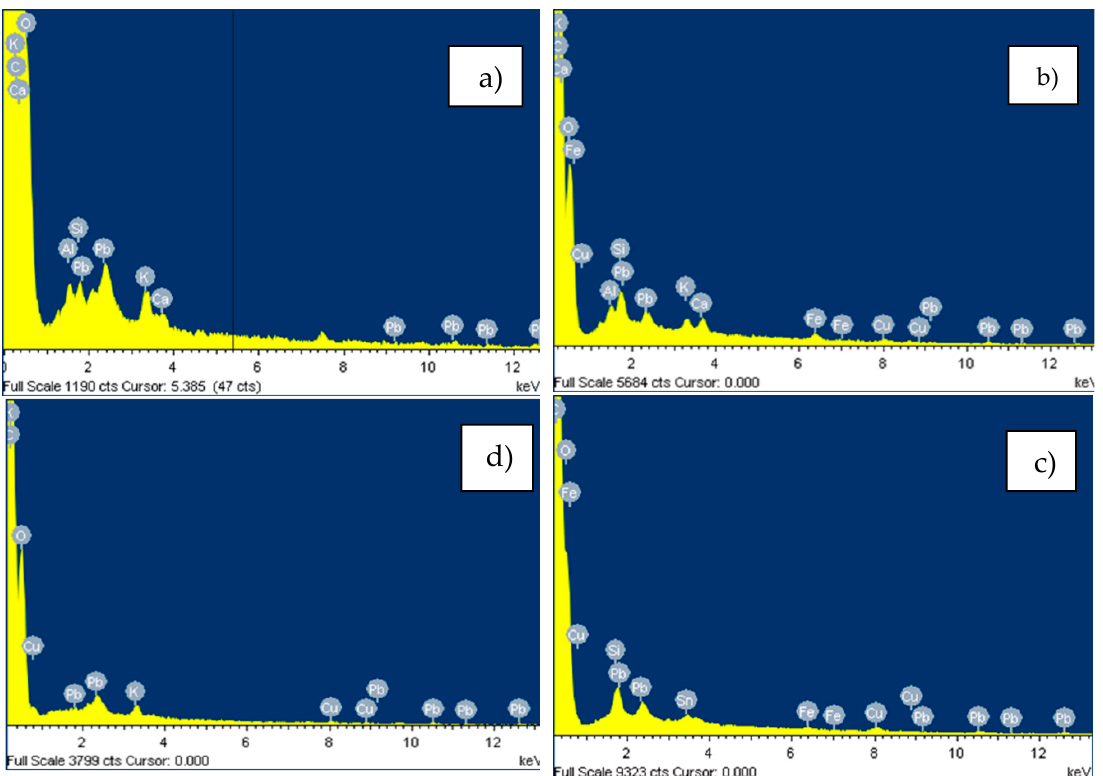
Figure 6. Energy Dispersive X-Ray spectrogram of: ( a ) YP, ( b ) CP, ( c ) BP, and ( d ) OPB biomasses after the adsorption process.